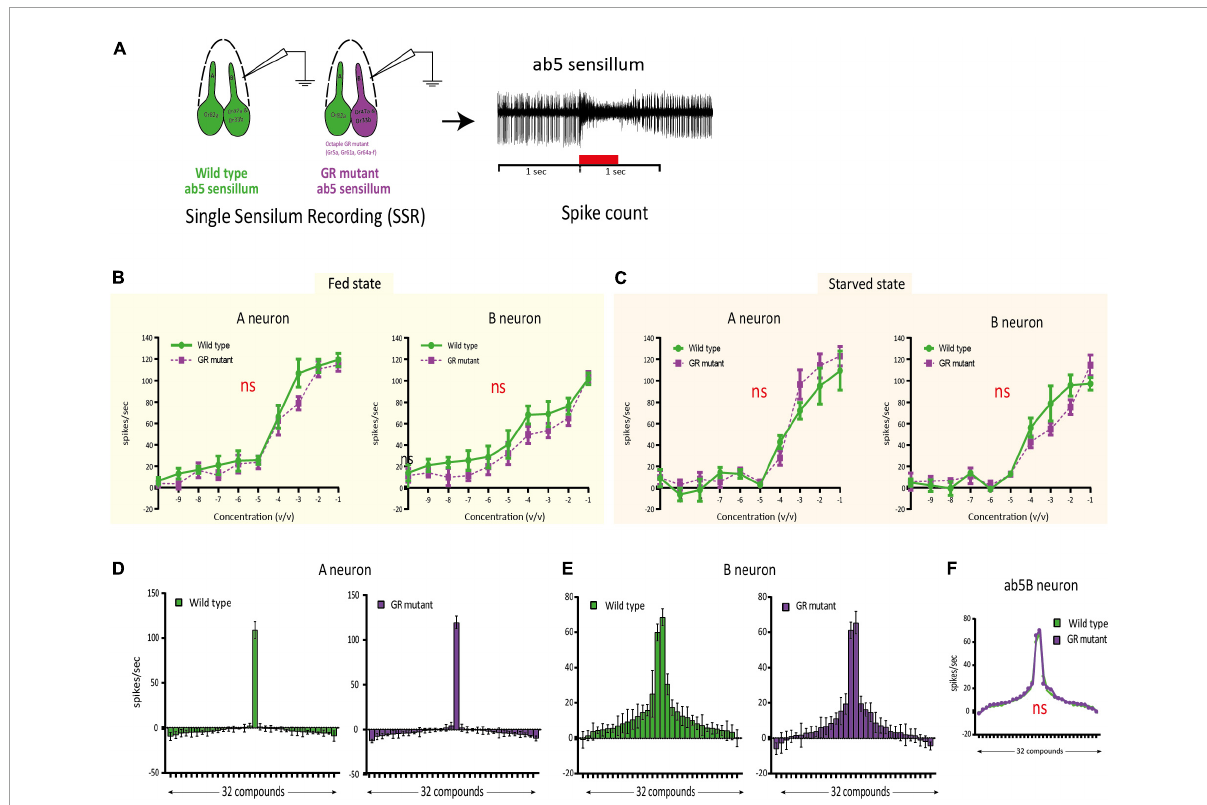
FIGURE3 Single sensillum recording (SSR) experiments confirming no functional involvement of Gr64b in modulating odor sensitivity of ab5B neuron in D.melanogaster . (A) Schematic representation of the methodology used to assess the functional role of Gr64b. SSR recordings were performed from the ab5 sensillum class in wild type CS fly and compared with an octuple GR mutant line [sugar blind fly, (Yavuz et al., 2014)] in two satiation states as fed and starved. Geranyl acetate and pentyl acetate were used as the best ligands for ab5A and ab5B neurons, respectively. (B,C) Dose response curves for both ab5A and ab5B neurons in fed and starved states with the green lines representing wild type CS fly and magenta line representing the octuple GR mutant fly. n = 4-6/ concentration. Unpaired, non-parametric t -tests with Mann Whitney test were performed at each concentration between two genotypes. No significant differences at each concentration were observed across experiments ( p > 0.05, unpaired t -test). The sensitivity was not changed between two genotypes tested (D,E) . (F–H) Odor tuning sensitivity of both ab5A and ab5B neurons were checked with a panel of 32 odors representing diverse chemical classes in wild type and octuple GR mutant fly lines in fed state in case of ab5A and ab5B neurons respectively (F,G) No significant shift in odor tuning curve in case of ab5B neuron was observed in absence of Gr64b (H) , n =